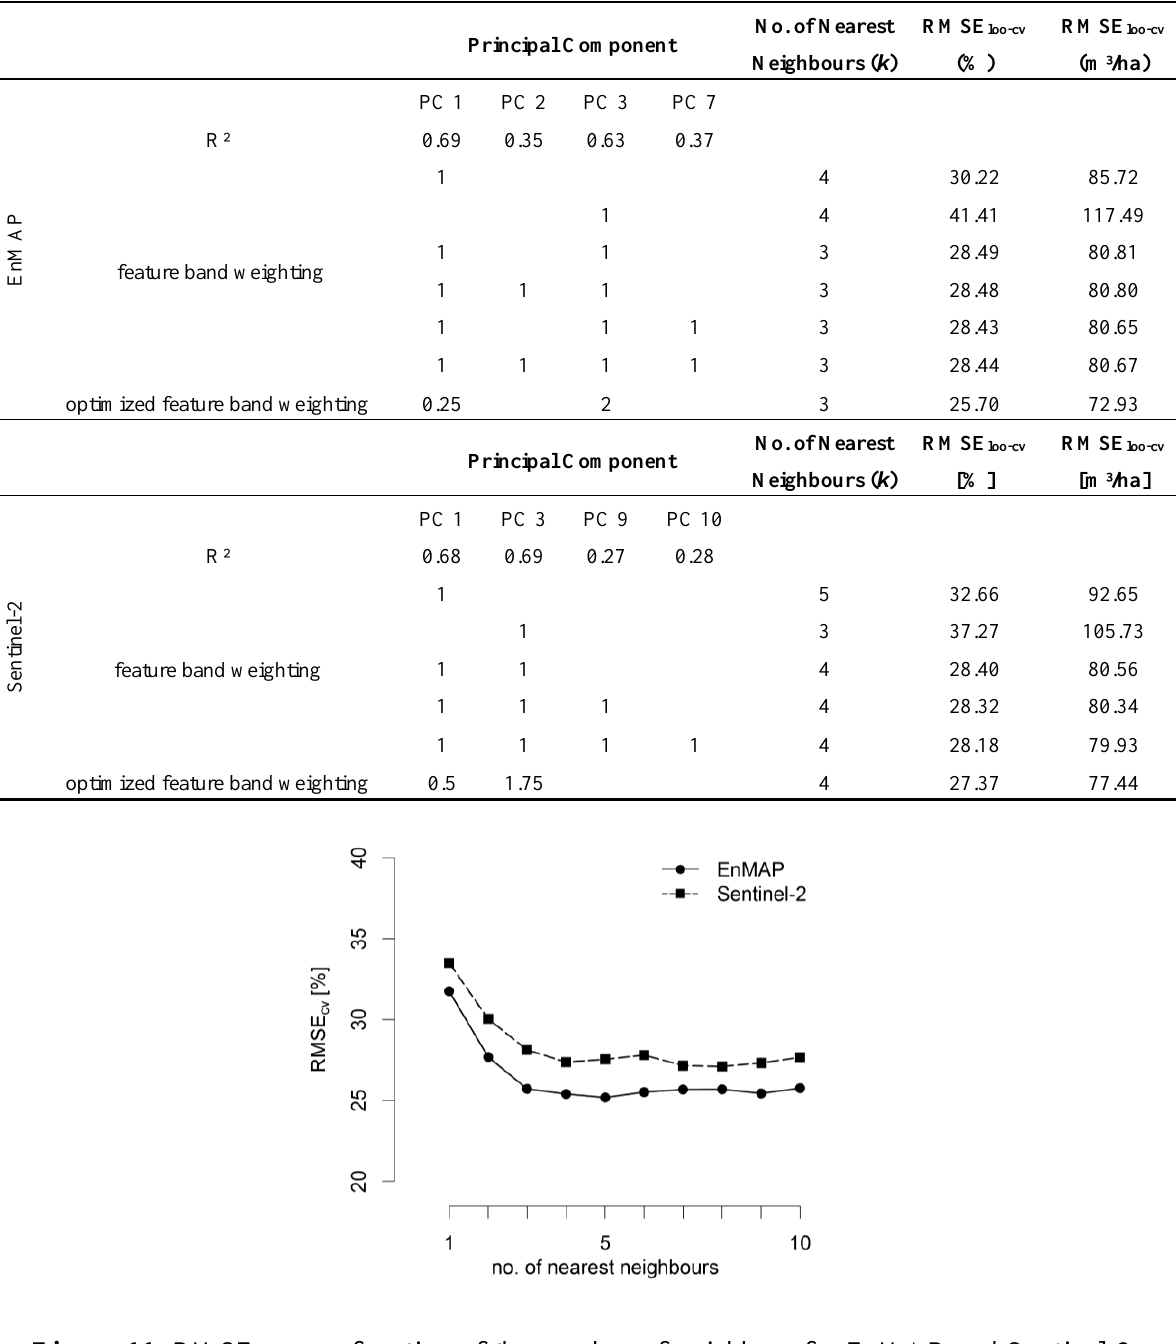
Figure 11. RMSEcv as a function of the number of neighbors for EnMAP and Sentinel-2 based optimized k -NN estimation, using PC1 and